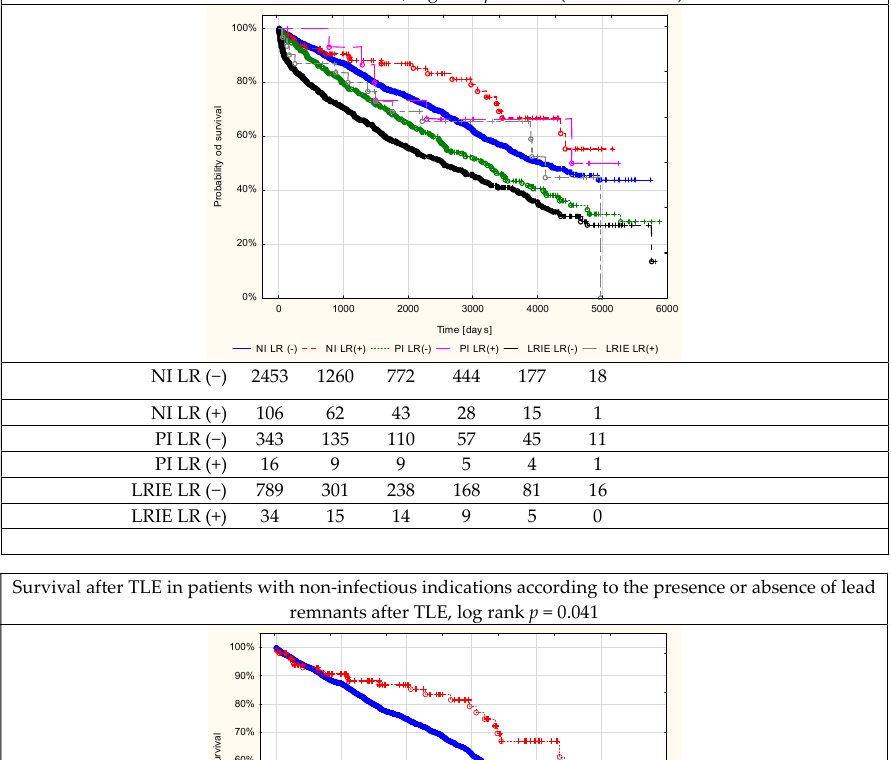
p = 0.265 1 Lead remnant after TLE—variant of multivariable model: (the lead tip); [HR = 0.909: 95% CI (0.596– 1.388); p = 0.660], (longer portion of the lead); [HR = 0.839: 95% CI (0.538–1.311); p = 0.441]. 2 Lead remnant after TLE—variant of multivariable model: (the lead tip); [HR = 0.973: 95% CI (0.549–1.724); p = 0.926], (longer portion of the lead); [HR = 0.999: 95% CI (0.562–1.776); p = 0.997]. 3 Lead remnant after TLE—variant of multivariable model: (the lead tip); [HR = 0.806: 95% CI (0.430–1.513); p = 0.502], (longer portion of the lead); [HR = 0.810: 95% CI (0.413–1.586); p = 0.537]. TLE—transvenous lead extraction; NYHA class—New York Heart Association functional class; LVEF—left ventricular ejection fraction; ICD—implantable cardioverter defibrillator—single chamber (VR) or dual cham- ber (DR); CRT-D—cardiac resynchronisation therapy cardioverter defibrillator. Survival after TLE in patients divided according to indications for TLE and the presence or absence of lead remnants after TLE, log rank p < 0.001 (for all models)